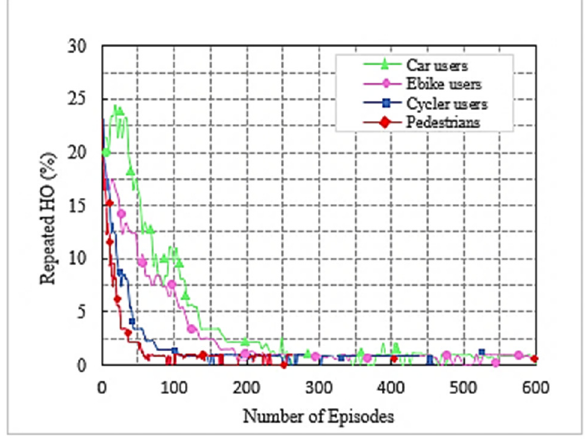
Figure 5. Number of wasteful HO as a function of the number of training episodes for DDPG only HO scheme.